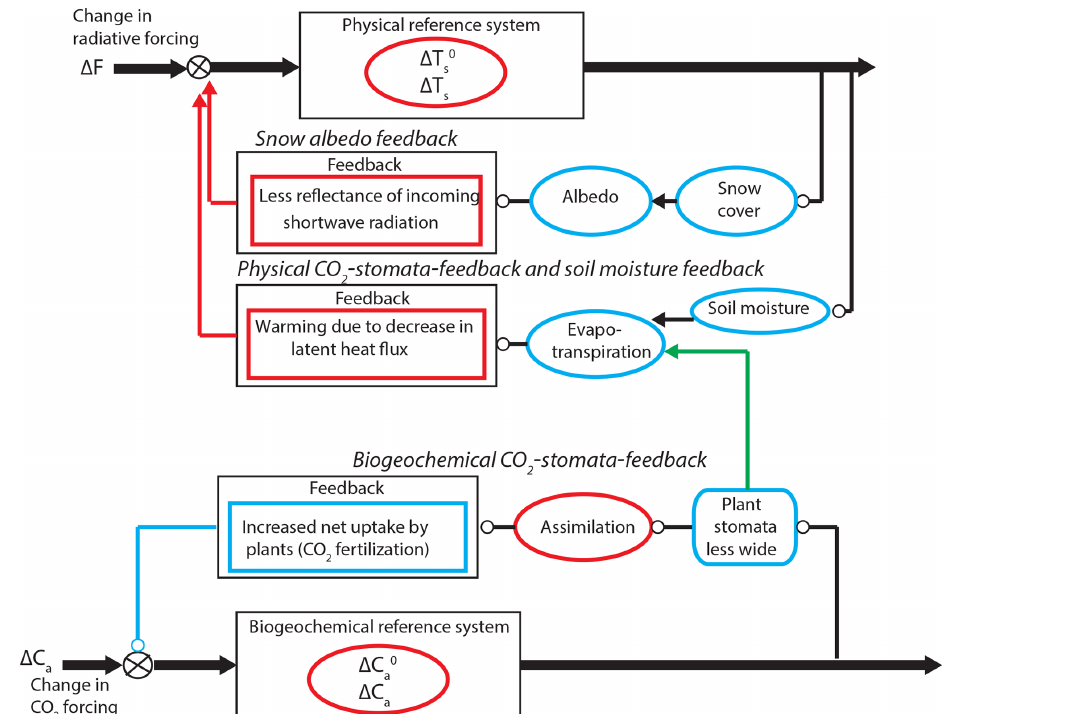
Figure 7. Schematic of important fast land surface feedbacks. Arrows indicate positive coupling; open circles indicate negative coupling. Changes in state variables are indicated by ellipses, changes in processes by rounded rectangles. Red indicates increasing values of variables, strengthening of processes, or positive feedbacks; blue indicates the opposite. Green arrows and lines indicate couplings of biogeochemical processes to physical processes. The change in surface air temperature (cid:49)T s in the presence of feedback is different from the change (cid:49)T 0 s without feedback (the change in greenhouse gas concentration (cid:49)C a in the presence of a biogeochemical feedback is different from that without such a feedback, (cid:49)C 0 a